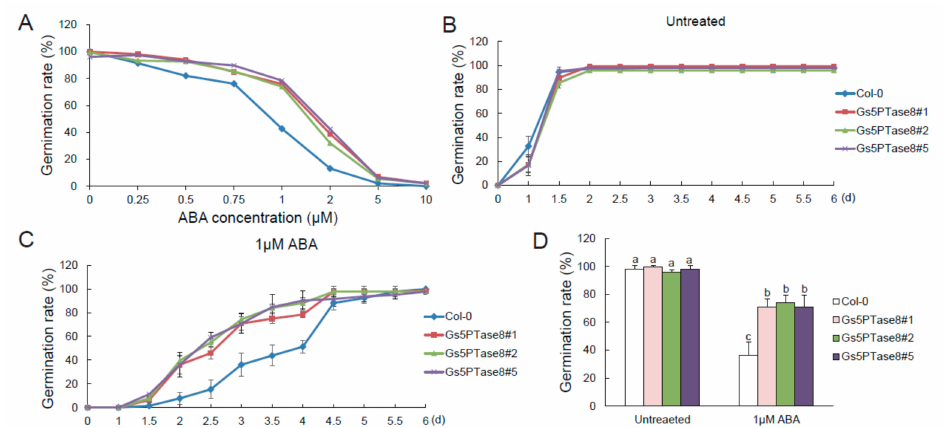
Figure 6. Germination of Gs5PTase8 -transgenic Arabidopsis under abscisic acid (ABA) treatment. ( A ) The germination rate under a series of ABA treatment. Arabidopsis seeds were sowed on 1 / 2 MS median with varied ABA (0, 0.25 µ M, 0.5 µ M, 0.75 µ M, 1 µ M, 2 µ M, 5 µ M, and 10 µ M), followed by being stratified at 4 ◦ C for 3 d and then shifted to 21 ◦ C. The germination rates were determined at around 3.5 d after seed imbibition for 150 seeds per line. ( B ) The germination rates were monitored every 12 h in 6 days after incubation at 21 ◦ C under normal conditions (untreated). ( C ) The germination rates under 1 µ M ABA treatment. ( D ) The statistical analysis of the germination rates at 3 d post stratification were performed by ANOVA with the Duncan’s post hoc test ( p < 0.05). The significant di ff erences were indicated by di ff erent letters above the bars. A total of around 400–500 seeds were used for each sample from three independent experiments.